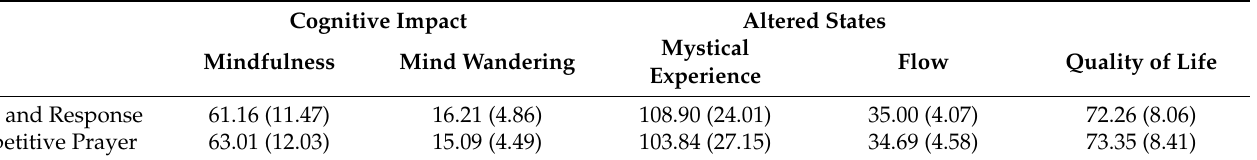
Table 1. Mean and Standard Deviation Scores by Chanting Style.